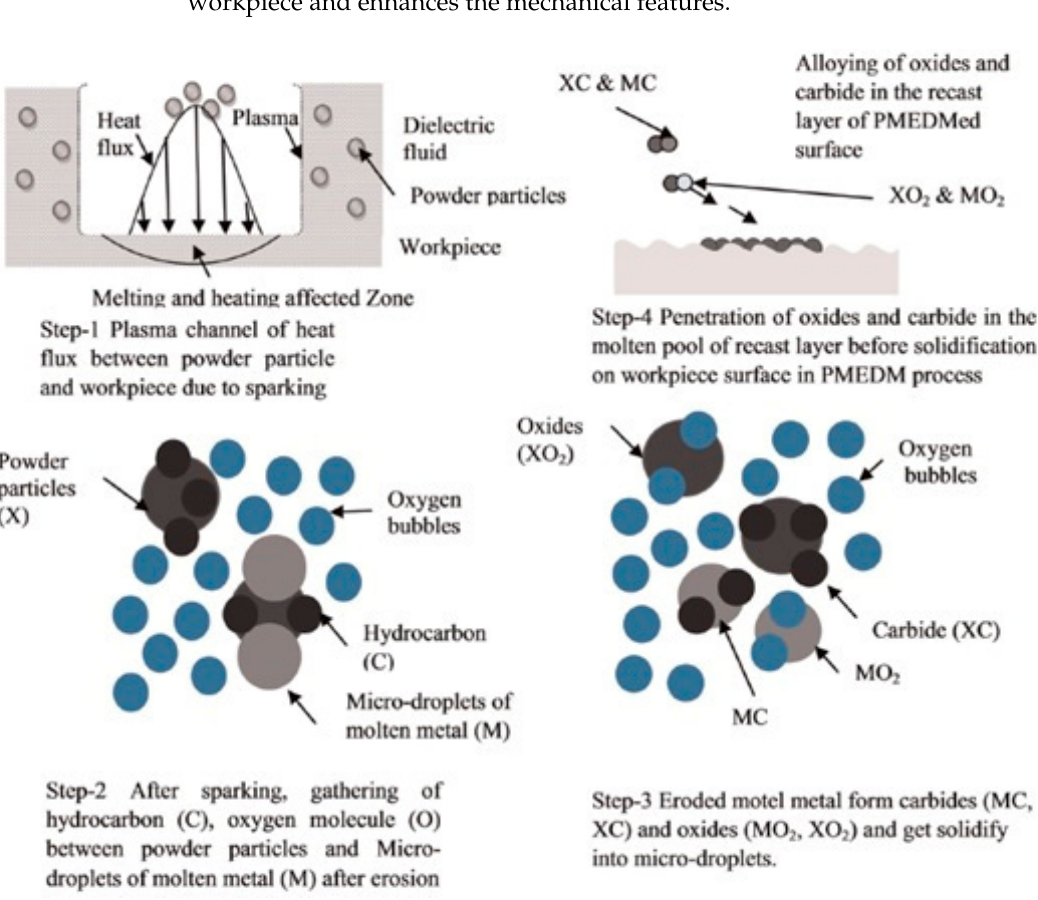
Figure 4. Schematic demonstration of material migration during the PMEDM process [24].